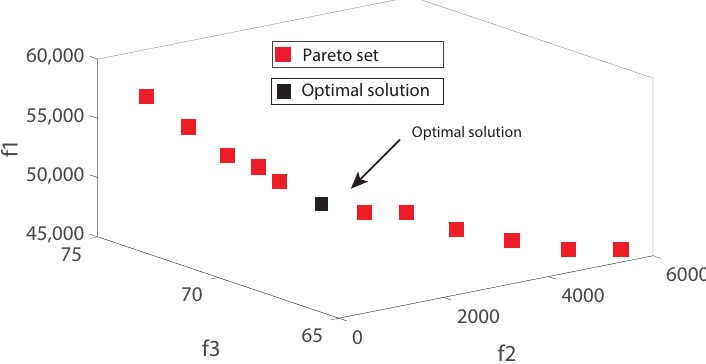
Figure 7. Tri-objective simultaneous optimization of ( F 1, F 2, F 3).